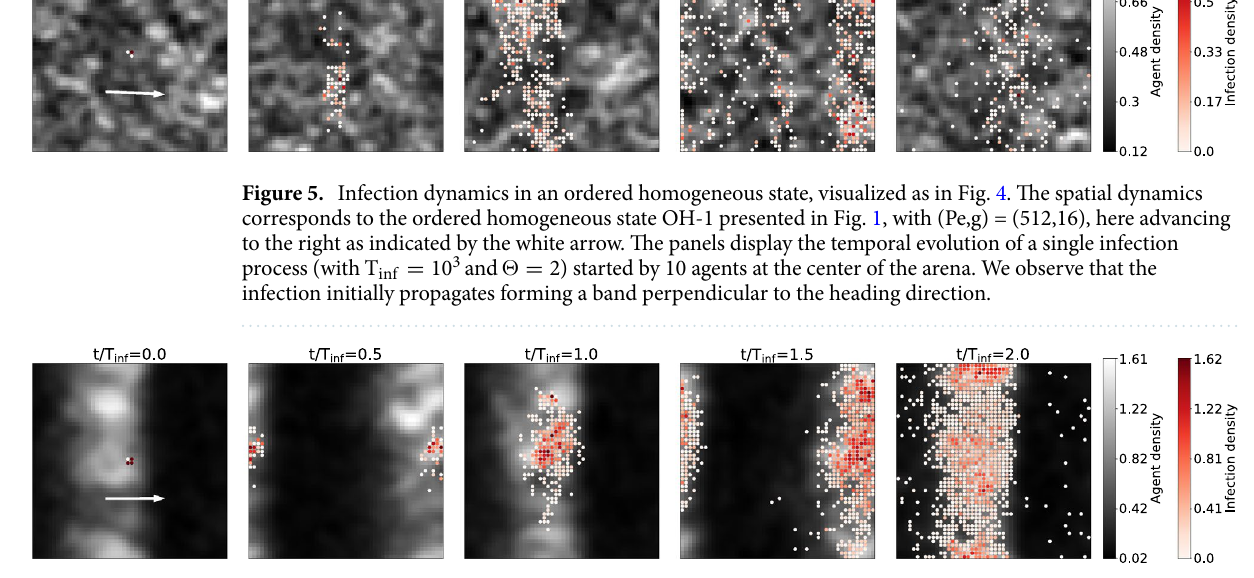
Figure 6. Infection dynamics in an ordered band state, visualized as in Fig. 4. The spatial dynamics corresponds to the ordered band state OB presented in Fig. 1, with (Pe,g) = (32,2), here advancing to the right as indicated by the white arrow. The panels display the temporal evolution of a single infection process (with T inf = 10 (cid:31) = 2 ) started by 10 agents within the band. We observe that the infection spreads first within the band, and then outside of the